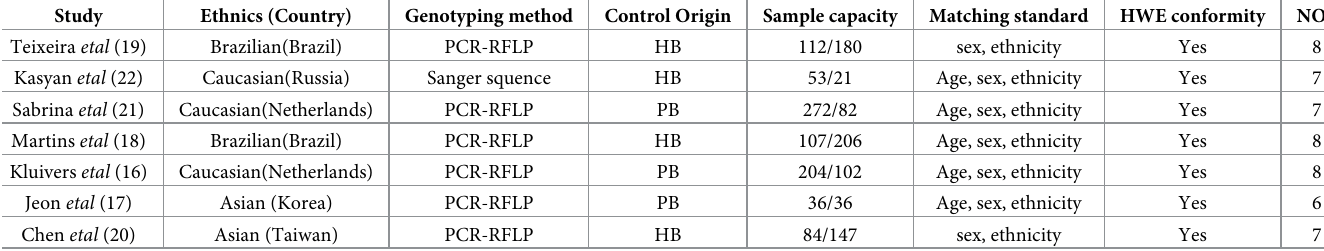
Table 1. General information of eligible studies enrolled in the meta-analysis.